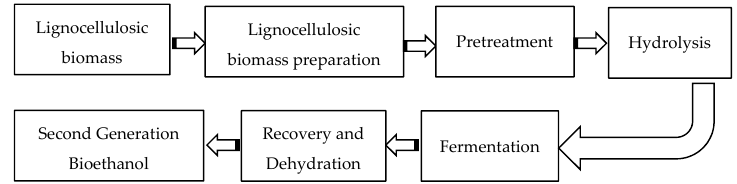
Figure 2. Pathway of ethanol production from lignocellulosic biomass.